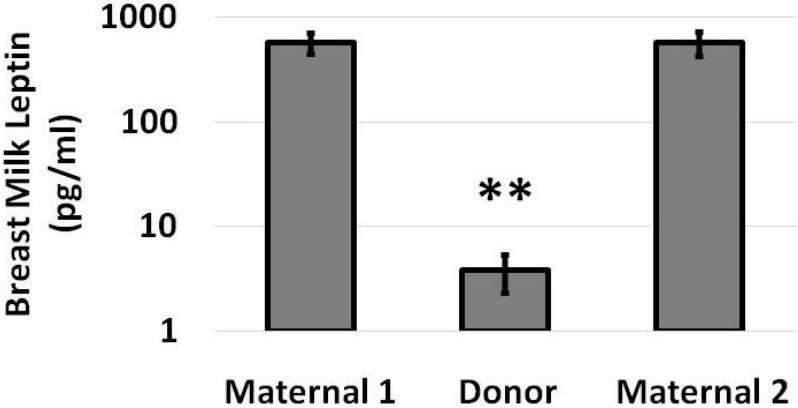
As shown in Figure 1, the mean leptin level in donor milk (3.8 pg/mL) was significantly lower than the leptin levels in maternal milk during the first or last week of the study (580 pg/mL and 577 pg/mL, respectively).